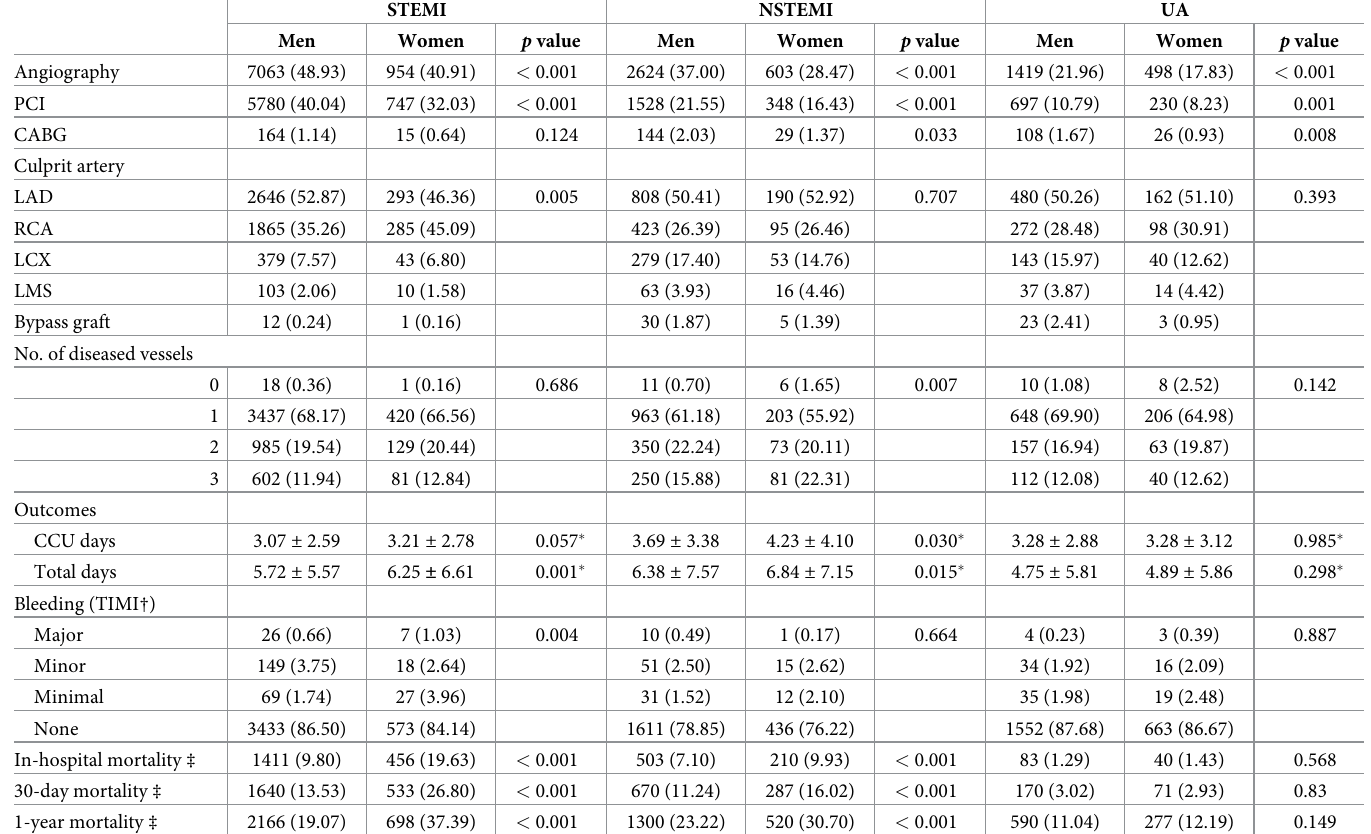
Table 3. In hospital procedures, culprit artery, number of disease vessels, and outcomes,